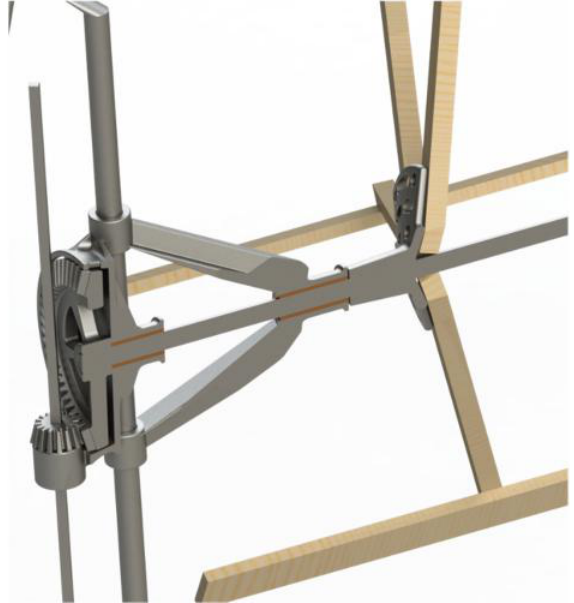
Figure 8. Sectional view of the sheaf pusher system.